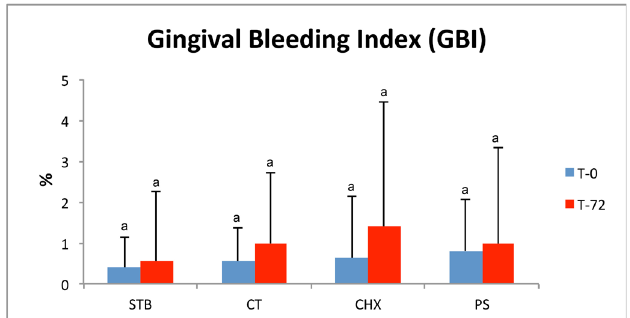
Fig.5. Mean (±SD) Gingival Bleeding Scores (DPI) for the treatments at baseline (T-0) and after 72 h (T-72) to single-tuft brush (STB), conventional toothbrush (CT), chlorexidine (CHX) and placebo solution (SP). Different lowercase letters indicate significant intragroup differences over time, by Student t test